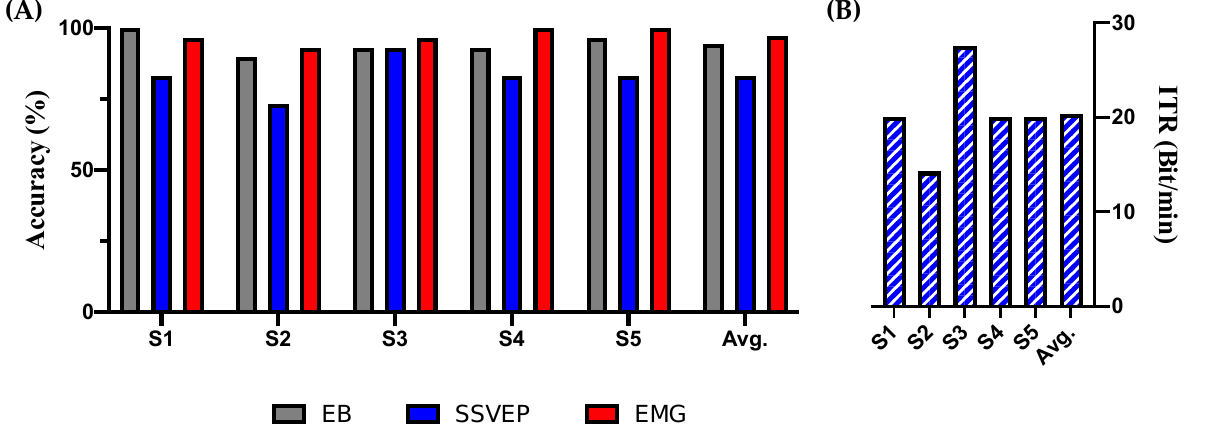
Figure 6. Results of the experiment. Performances of steady state visual evoked potential (SSVEP) were used for three channels and 4 s of data. ( A ) Accuracy of triple eye-blink (EB), SSVEP, and electromyogram (EMG). ( B ) Information transfer rate (ITR) of SSVEP.